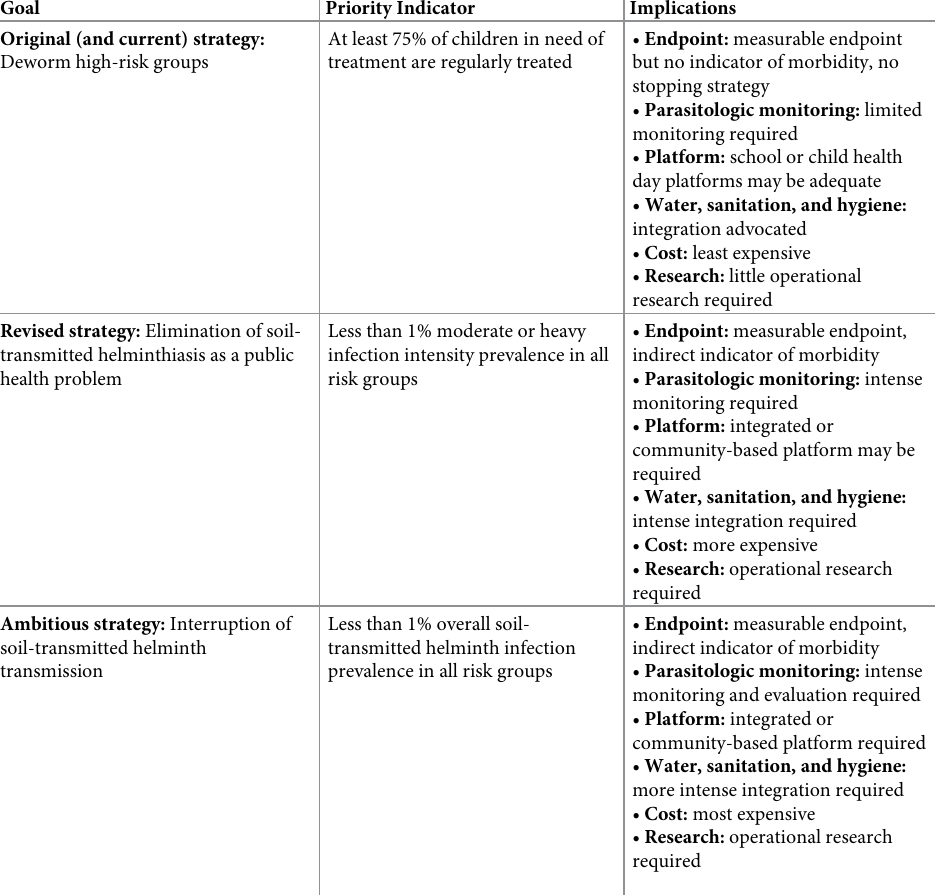
Table 4. Key characteristics of 3 different strategies pertaining to future soil-transmitted helminthiasis control